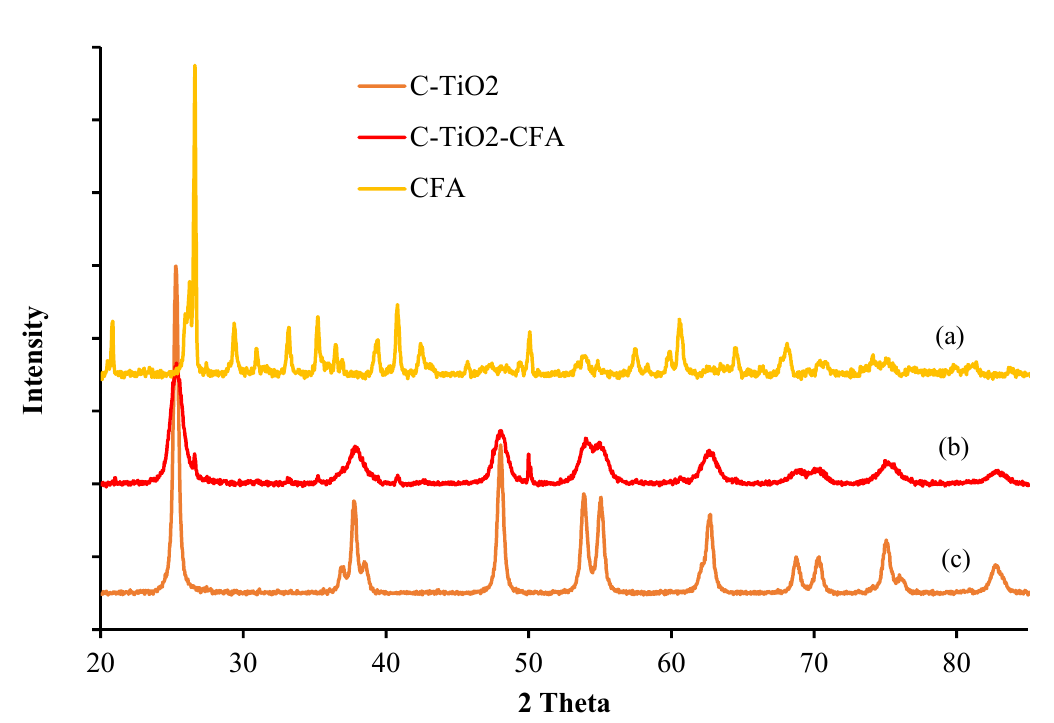
Figure 2. XRD patterns of ( a ) CFA, ( b ) C-TiO 2 -CFA/PAN, and ( c ) C-TiO 2.